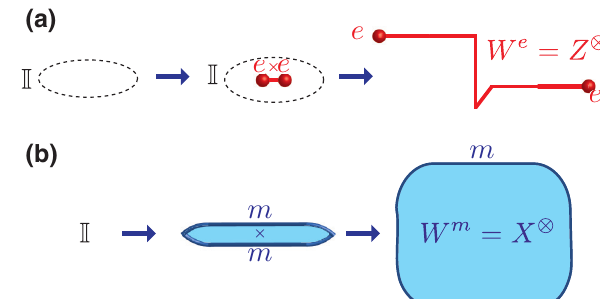
FIG. 10. An illustration of the Z 2 fusion rules of the e -particles and m -strings, respectively. (a) A pair of e -particles can be cre- ated out of the vacuum I via a Wilson line W e in between, which corresponds to a Z -string operator Z ⊗ in the 3D toric code model. (b) A pair of m -strings forming an m -loop can be created out of the vacuum I via a Wilson sheet W m in between, which corresponds to an X -brane operator X ⊗ in the toric code.